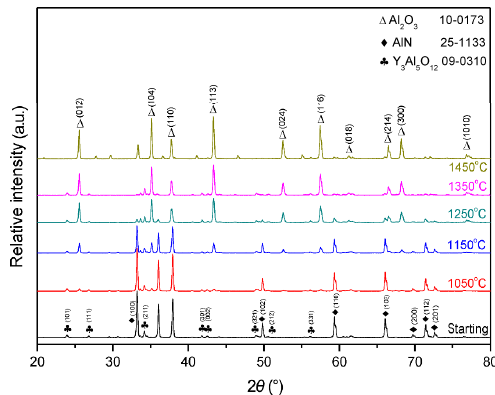
Fig. 2 XRD patterns for AlN specimens oxidized at various temperatures for 4